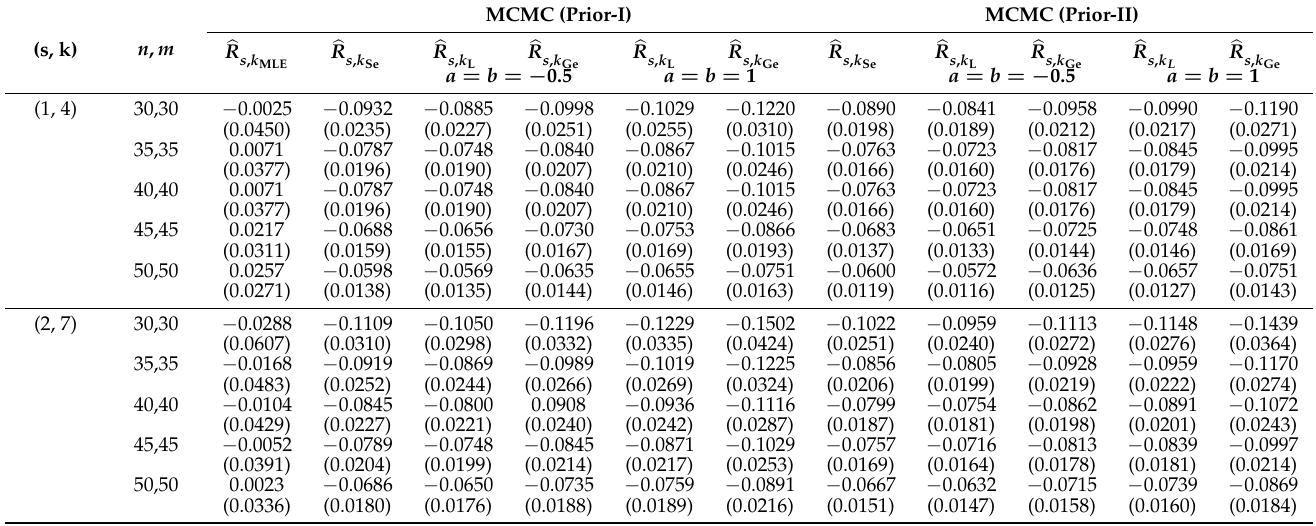
Table 5. The rBias and rMSE (in parentheses) for Case 2, ( α , λ 1 , β , λ 2 ) = ( 1.5, 1, 2, 1 ) and T = 5.